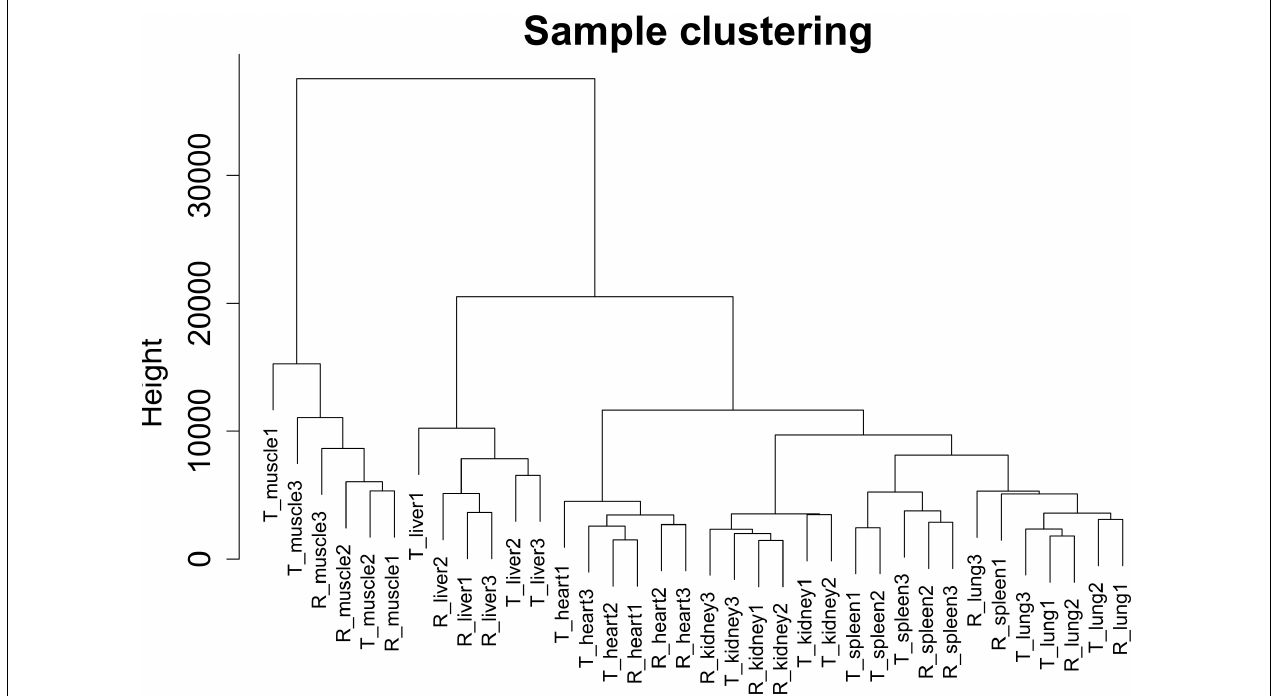
FIGURE 2 | Clustering dendrogram of 36 tissue samples of Tibetan pigs and Rongchang pigs. The figure shows the clustering of a total of 36 tissue samples of Tibetan pigs and Rongchang pigs, where “T” represents Tibetan pigs, and “R” represents Rongchang pigs. For example, “T_muscle1” represents the muscle sample of the first individual Tibetan